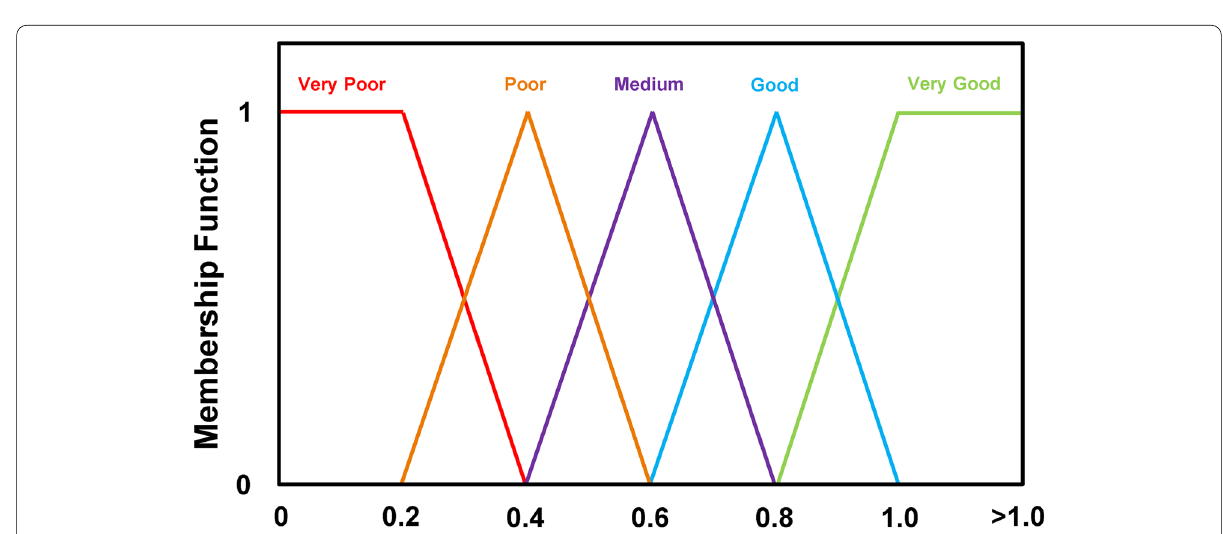
Fig. 7 Membership function of the evaluation